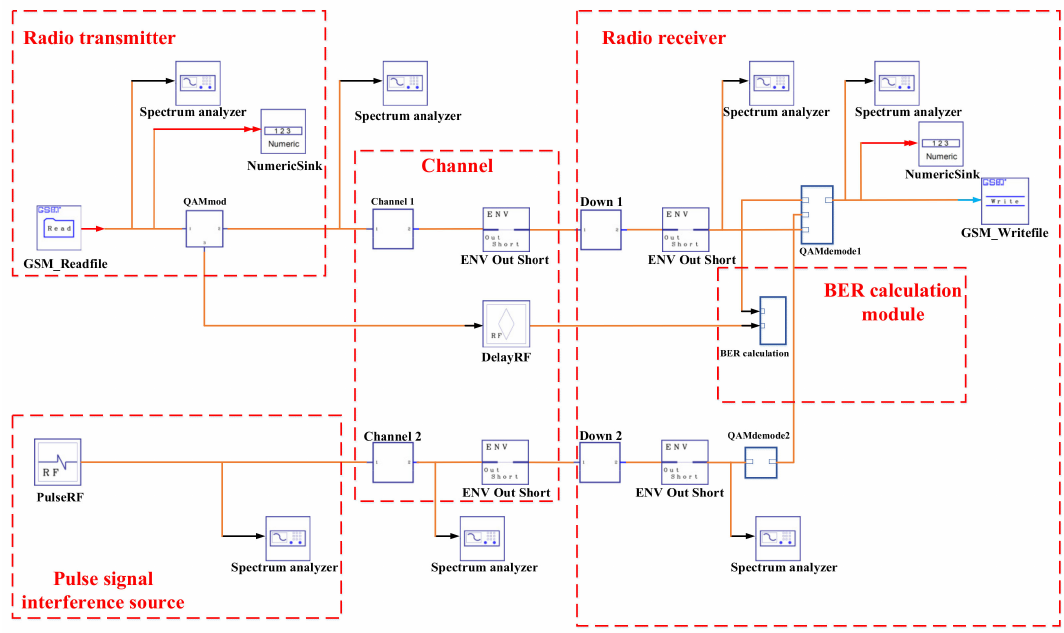
Figure 8. Diagram of the behavioral